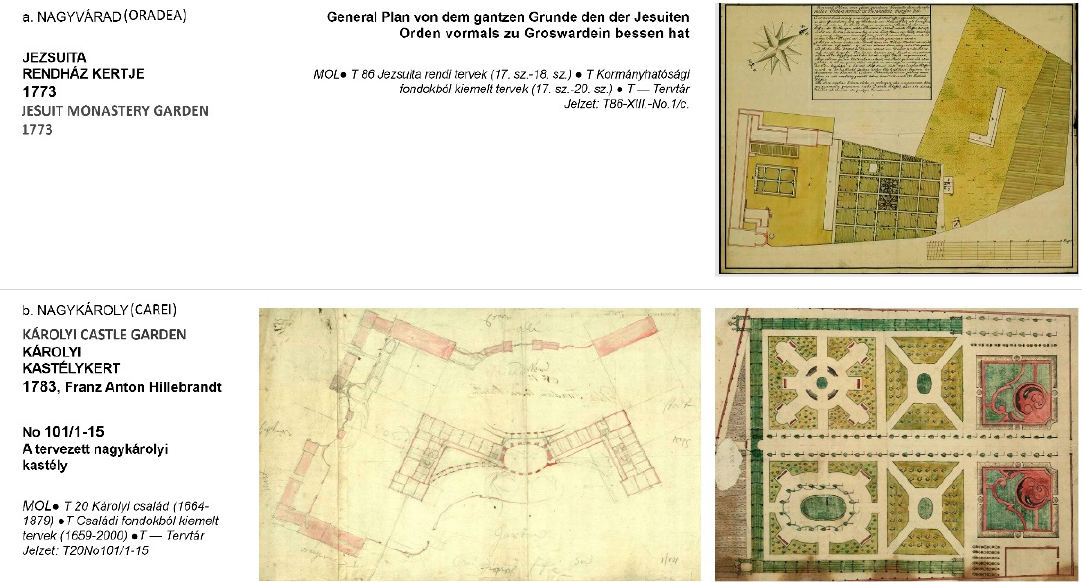
Figure 5. Source: compiled by Albert Fekete. ( a ). The Baroque garden plan of Hillebrandt from 1783 for the Károlyi Castle in Nagykároly (Carei, RO) based on “ A tervezett nagykárolyi kastély ” [68]. ( b ). The Baroque garden plan from 1773 for the Jesuit monastery in Nagyvárad (Oradea, RO) based on “ General Plan von dem gantzen Grunde den der Jesuiten Orden vormals zu Groswardein besessen hat ” [69]. The manuscript map of the R á k ó czi-Bornemisza Castle in Radn ó t (Iernut, RO), which was the seat of the prince in the 17th century, shows two very simple orthogonally divided geometric gardens on the west and south-west sides of the castle in the early 19th